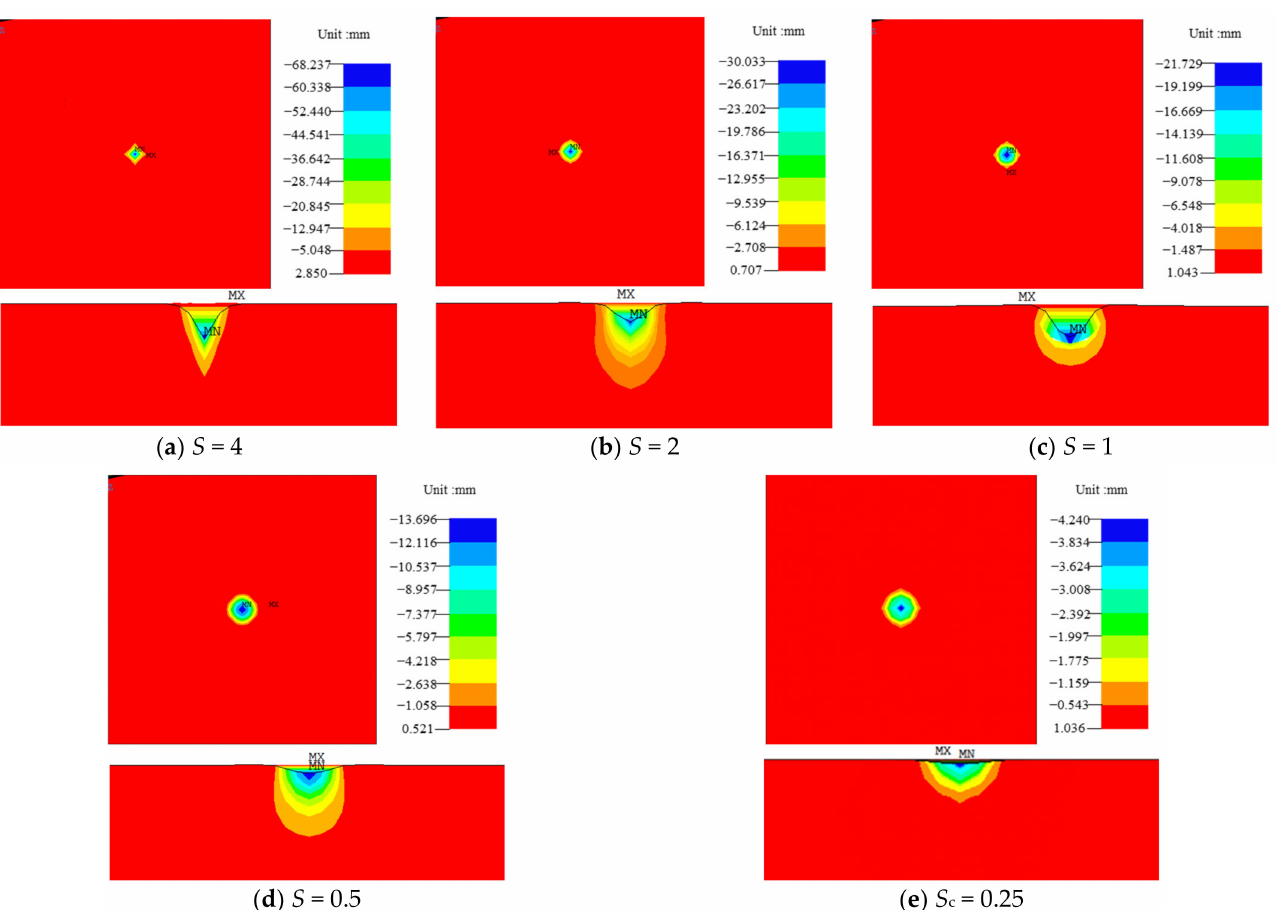
Figure 11. Penetration depth of sand cushion impacted by falling stones of different shapes in numerical simulation. ( a – e ) correspond to five different shapes of rockfall,